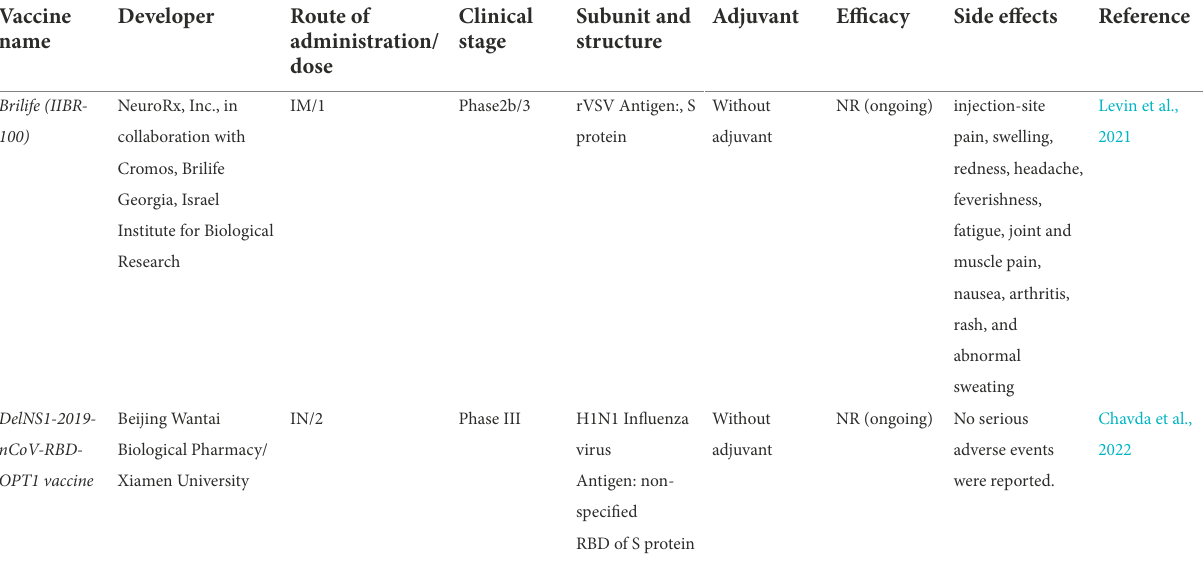
TABLE 4 Characteristics of COVID-19 replicating viral vectors vaccines. Vaccine